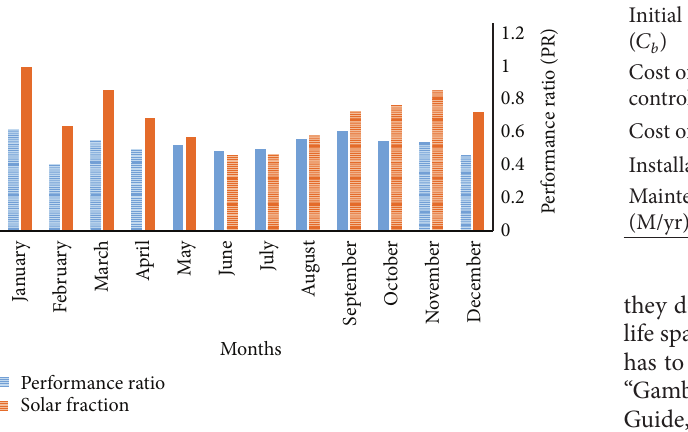
Figure 12: Performance ratio and solar fraction.